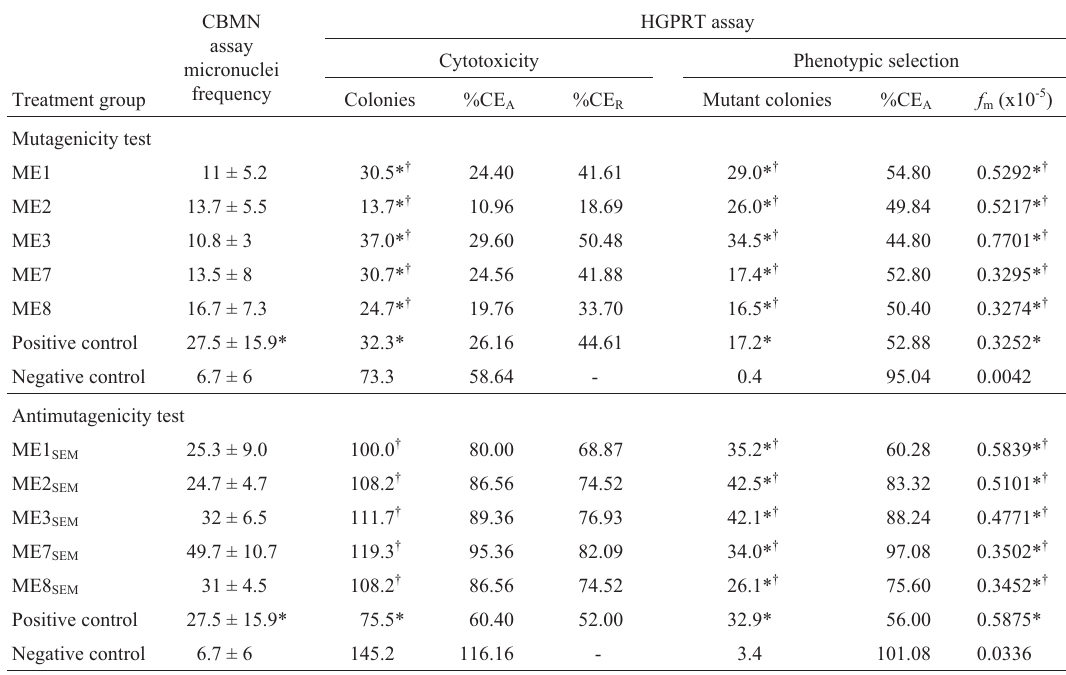
Table 1 - Cytokinesis-block micronucleus (CBMN) assay and hypoxanthine-guanine phosphoribosyl transferase locus (HGPRT) assay results for